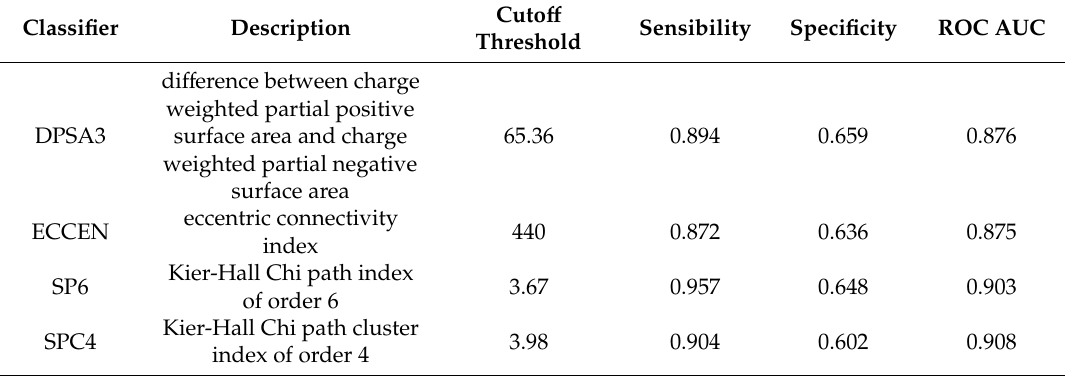
Table 4. Statistics and description of selected